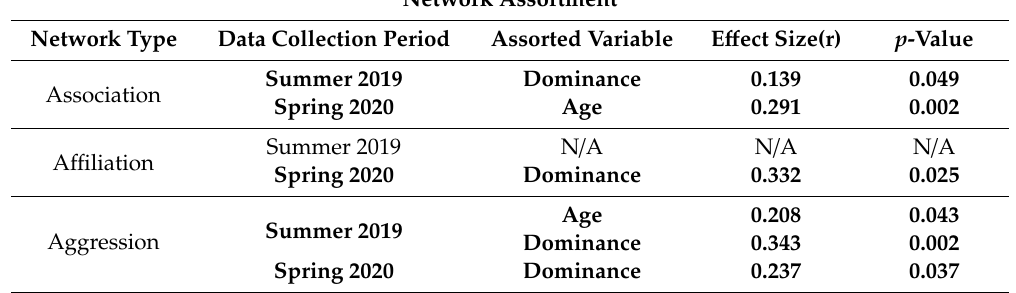
Table 2. This table shows the factors (age, sex, or dominance) predicting assortment, the e ff ect size estimate of that variable and the statistical significance of that result. Statistically significant results are highlighted in